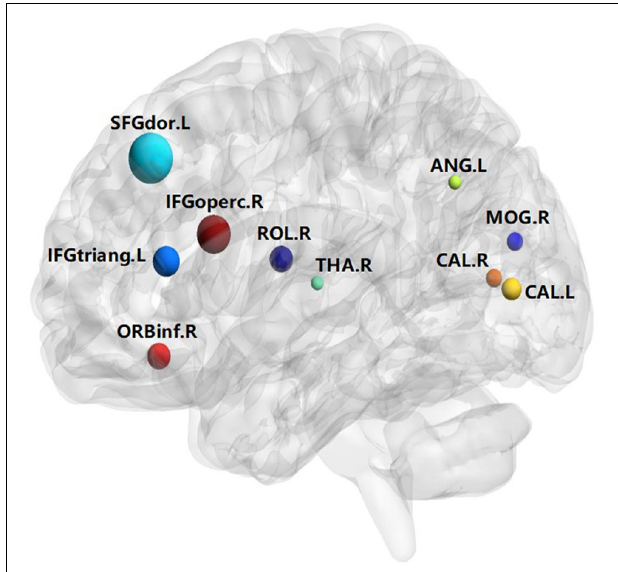
FIGURE 6 | Visualized ROIs selected from low-order FC networks.